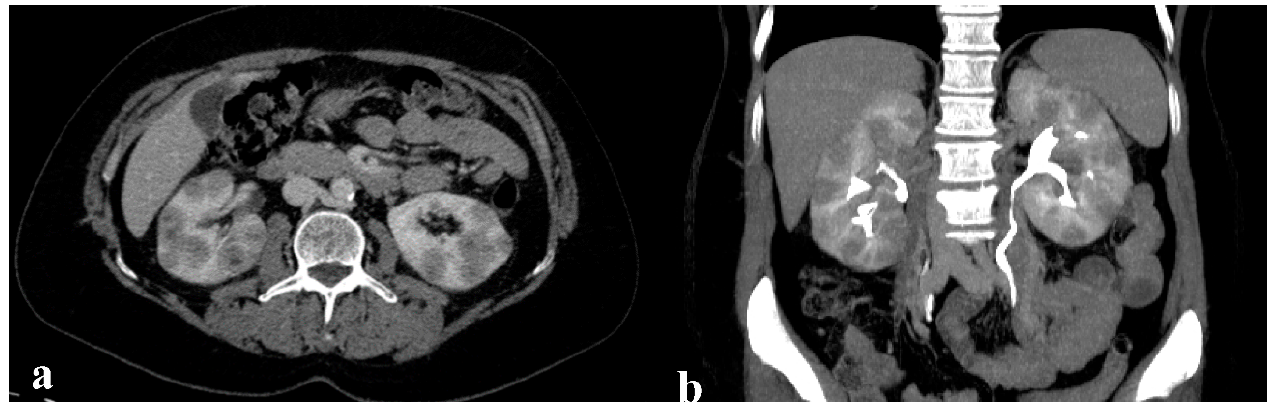
Figure 1. CT imaging placing the suspicion of the lymphoproliferative disorder. ( a ) Axial acquisition after the contrast medium injection: multiple hypodense nodular masses with defined margins are clearly evident in both kidneys in the cortical area. Renal veins are patent with an occasional accessory retroaortic left renal vein. Neither mesenteric nor retroperitoneal adenomegalies are evident. ( b ) MPR reformatting of excretory phase: typically, the renal pelvis is well-defined without infiltrations signs. Note: spleen volumetry is normal.